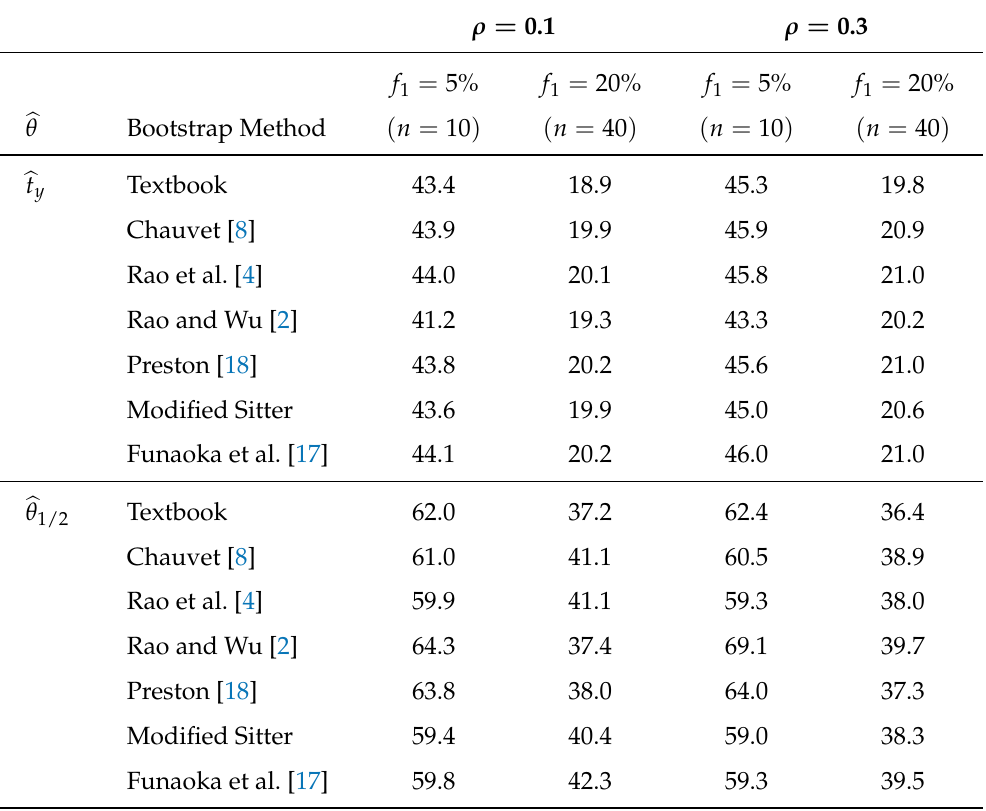
Table 3. Monte Carlo percent CV based on 3000 samples selected according to SRSWOR/SRSWOR.